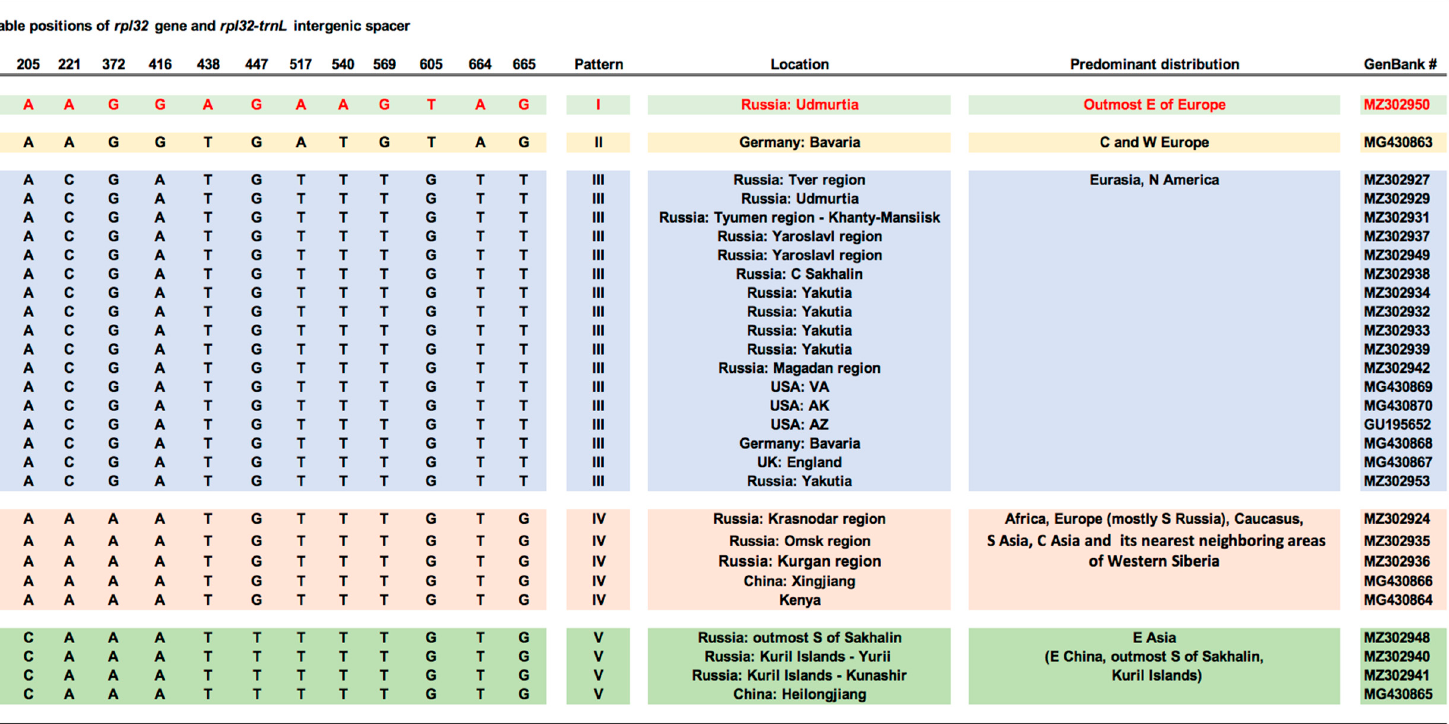
Figure 8. The summary of five (I.–V.) patterns in variation of the plastid ( rpl32 gene— rpl32-trnL intergenic spacer) sequence data matrix of all analyzed species of Typha sect. Ebracteolatae were conducted with a special focus on T. lepechinii sp. nov.